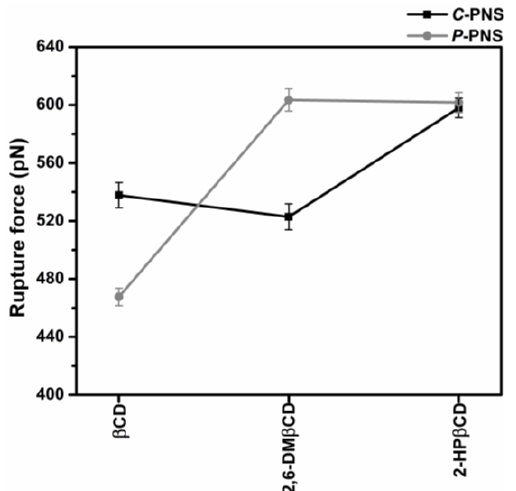
Figure 5. Rupture force (F max , pN) derived from the force-time profile of pulling the two oriented ligands, C -PNS and P -PNS, out from the wider rim along the host cavity axis for each inclusion